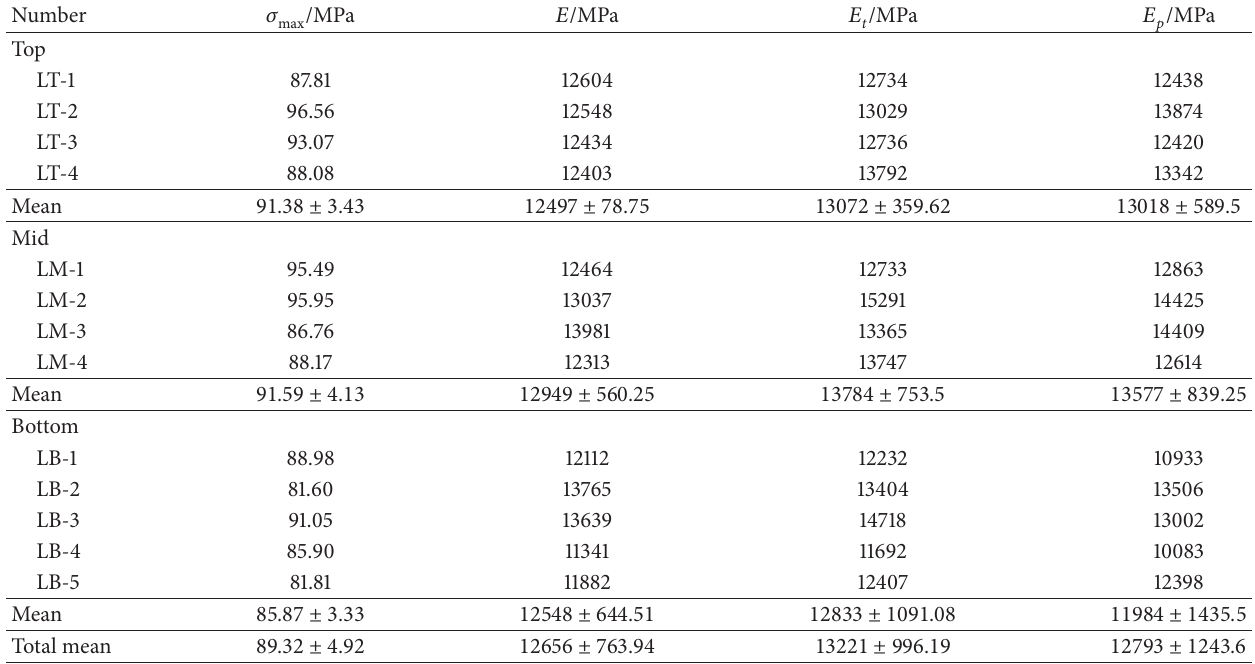
Table 1: Test results of